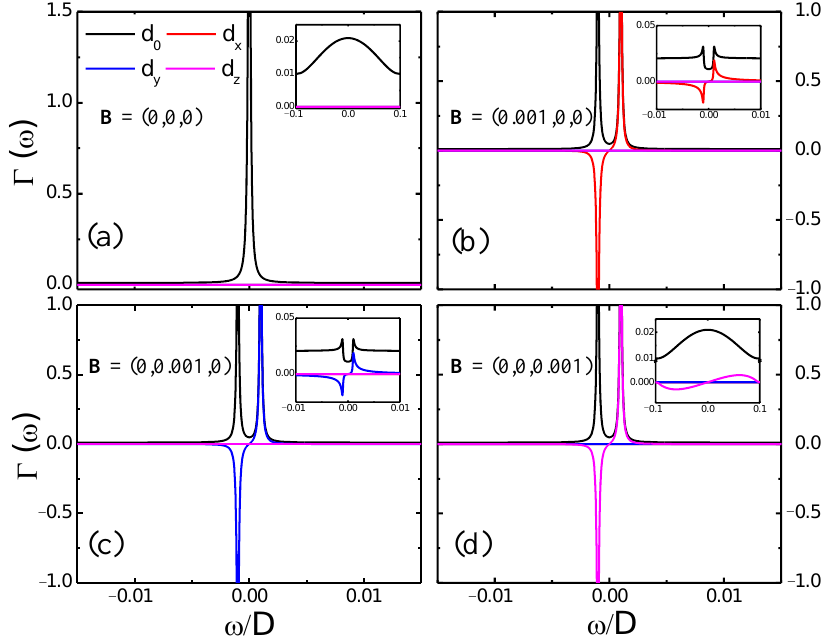
Figure 3. ( a – d ) Hybridization function coefficients d α = 0, x , y , z ( ω ) for applied magnetic field along different directions, for an impurity placed at the hollow-site configuration (at the edge). The insets show the coefficients for λ SO = 0.1. For all panels N = 26 and V 0 =